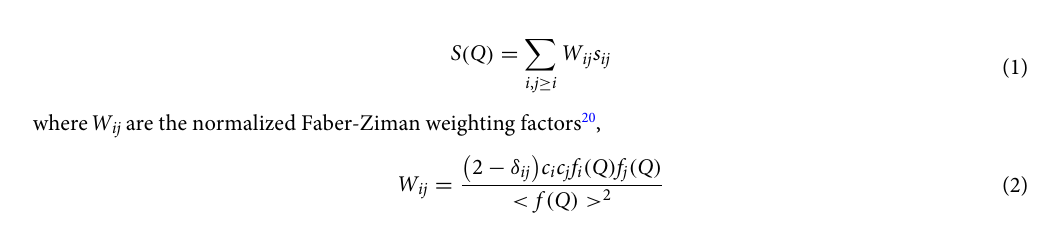
Figure 4. First order difference functions for Ti (green) and Nd (red) after dividing by the appropriate weighting factors for the first peaks to correspond to unweighted Ti-O and Nd-O partial pair correlations. The integration limits used to extract coordination numbers are marked with colored dots. Experimental and EPSR results are shown with solid and dashed curves,